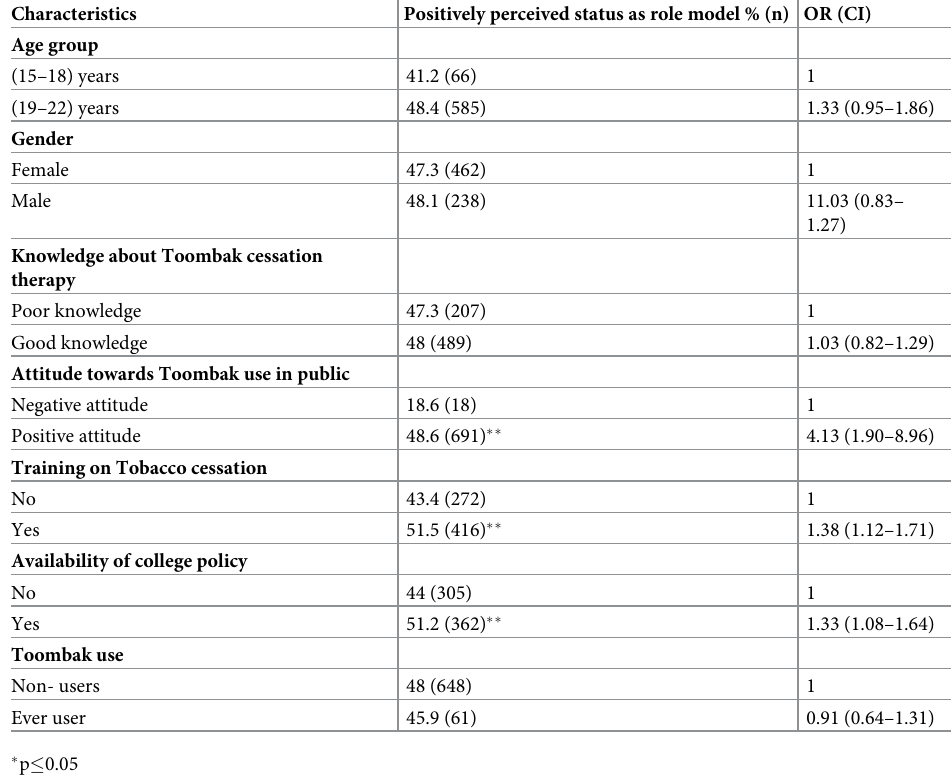
Table 2. Percentages, OR and CI of perceived positive role model status by demographic characteristics, formal training, college policy, Toombak use, knowledge and attitudes towards Toombak cessation.